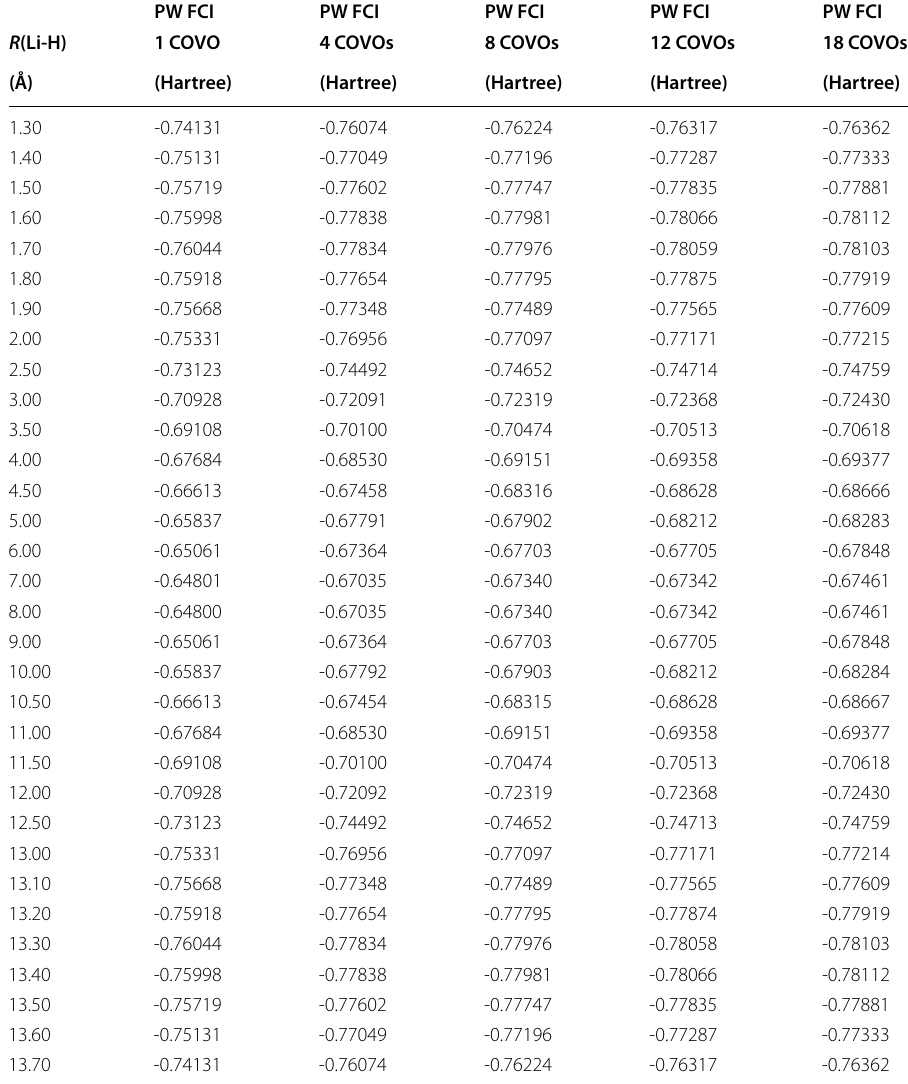
Table 2 Total energies as a function of distance for the LiH molecule from periodic plane-wave FCI calculations with 1, 4, 8, 12, and 18 COVOs. A simple-cubic supercell (L 15.0 Å) was used = PW FCI PW FCI PW FCI PW FCI PW